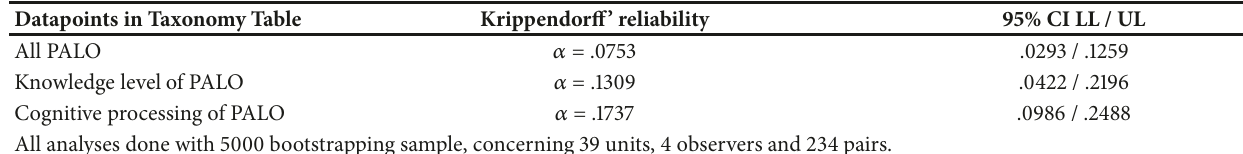
Table 2: PALO encoding